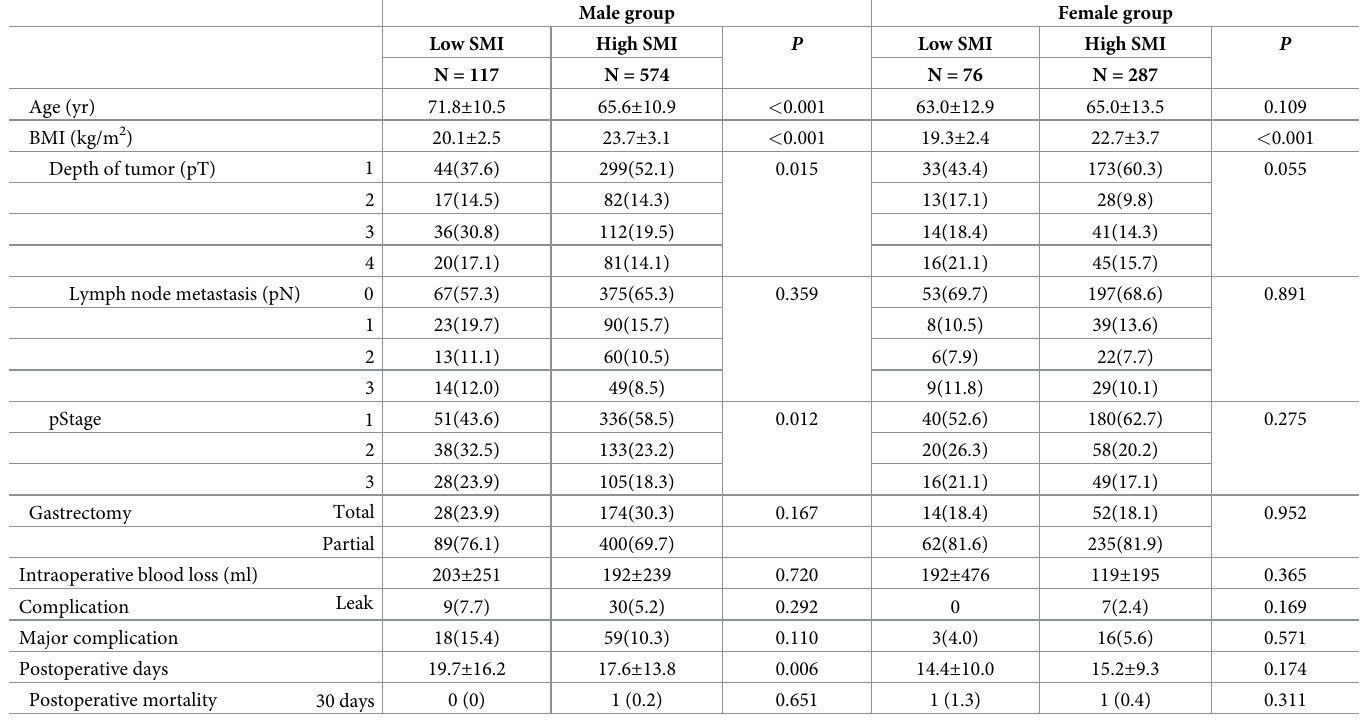
Table 1. Clinicopathologic characteristics in the low- and high-SMI groups of men and women